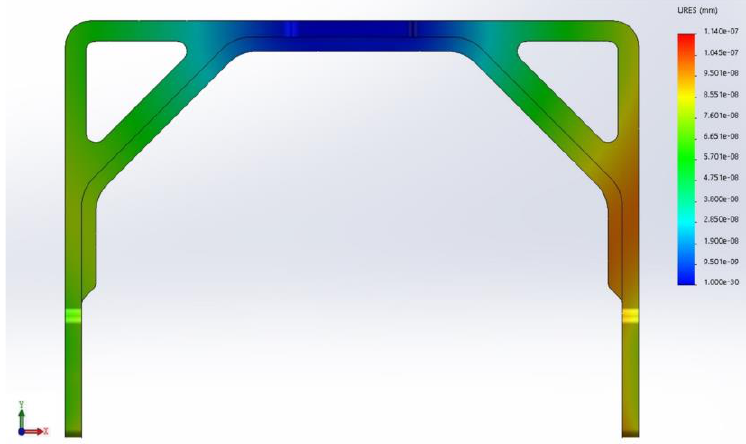
Figure 5. Mechanical-performance analysis of the yaw axis frame.